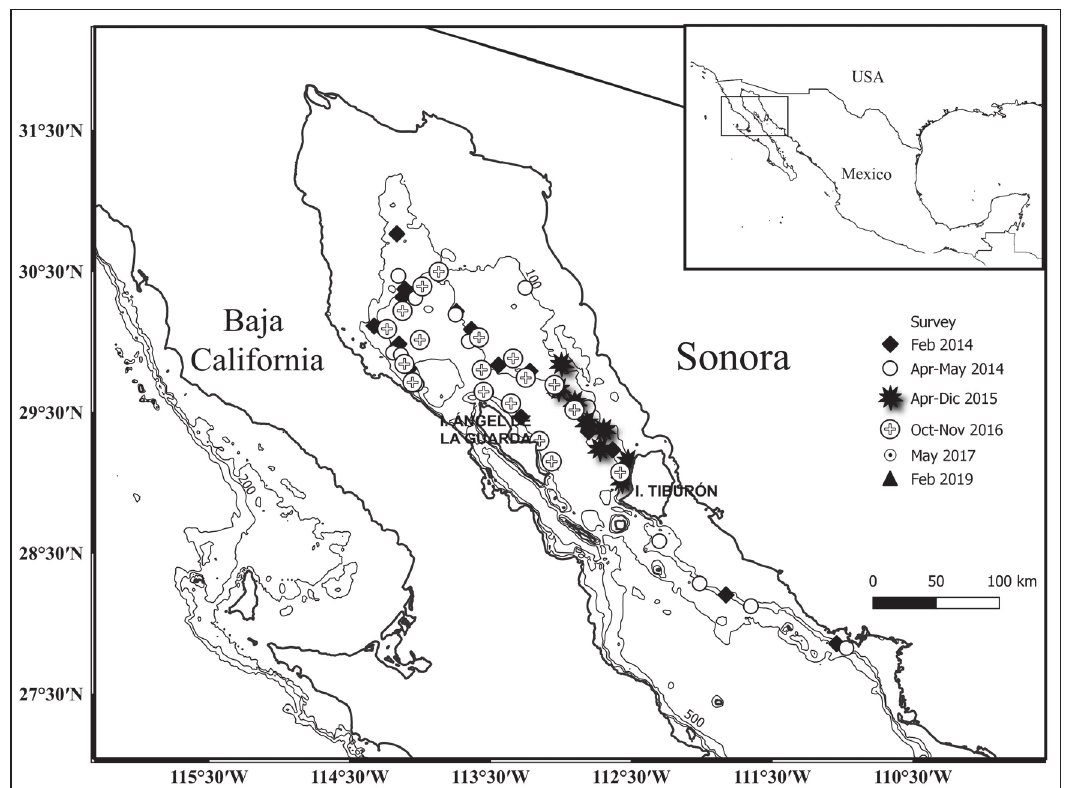
Figure 1. Study area the middle and northern Gulf of California, and sampling stations during research cruises.